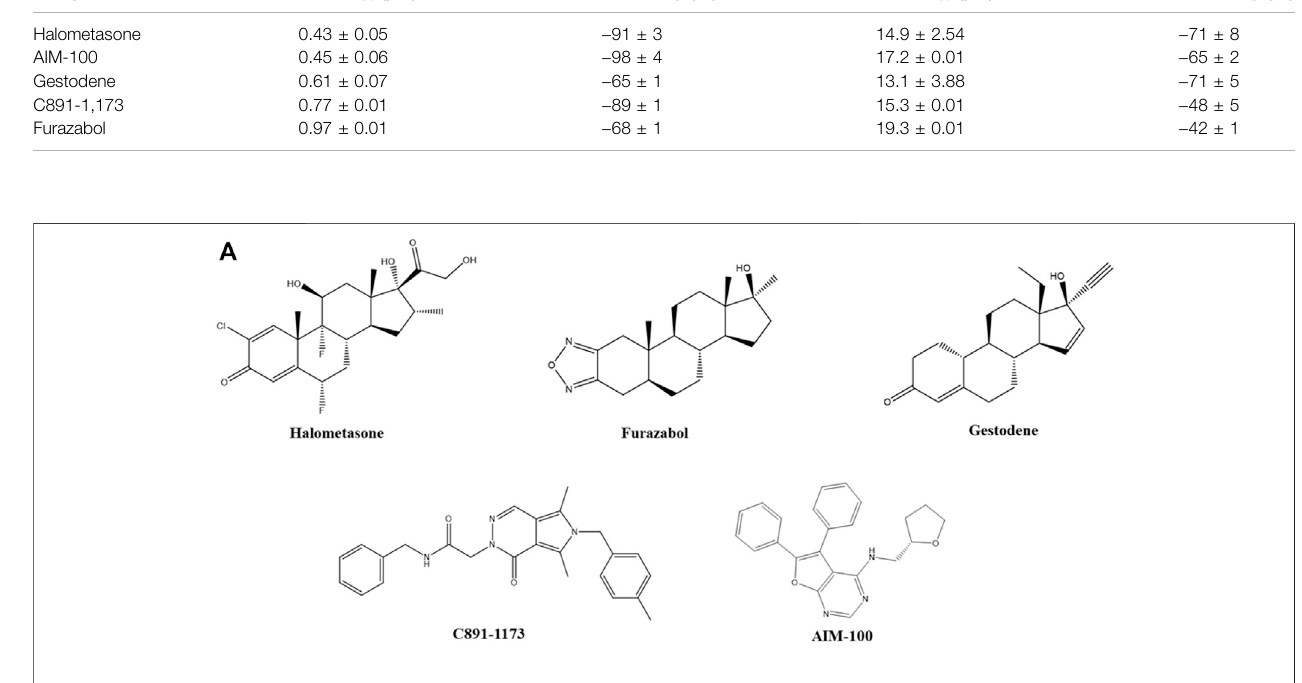
Figure 6B . Out of the remaining 64 compounds, 28